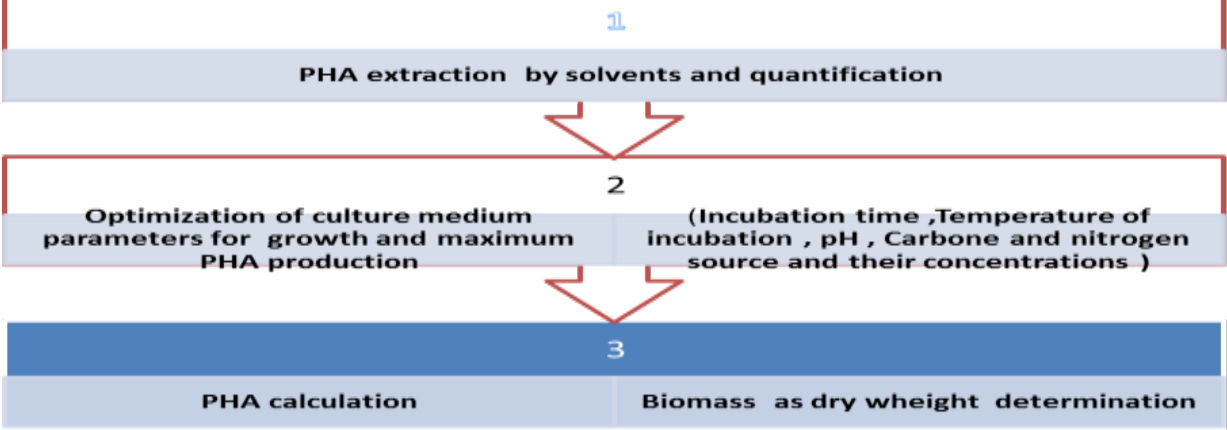
Figure 1: Schematic diagram of PHA extraction, quantification, and improvement of growth